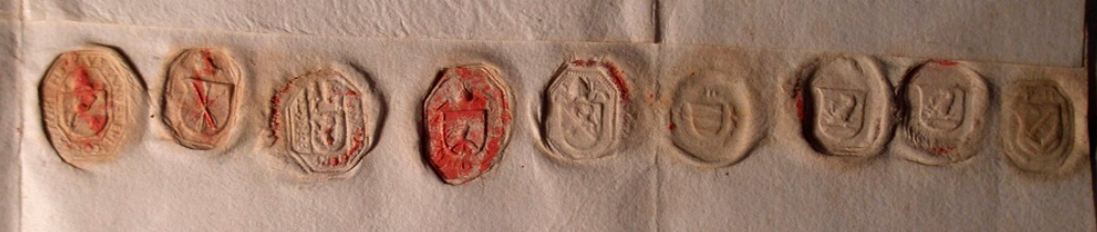
Figure 8. Seals from the letter of the dignitaries dispatched to the city of Kassa/Kaschau/Košice after the death of King Matthias in 1490. Archiv mesta Košice, Archivum Secretum, “F” Tellonium Nr. 102.